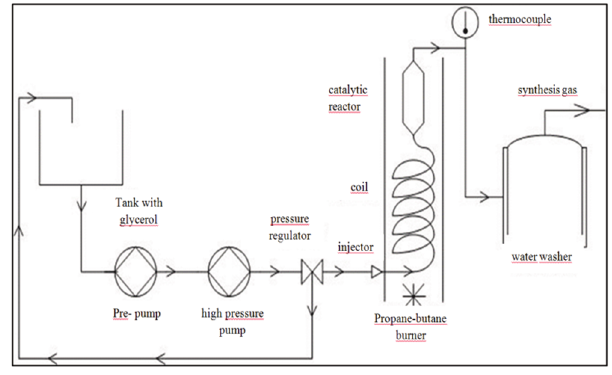
Fig. 6. Diagram of the installation for the production of syngas During the attempts to obtain syngas, both pure glycer- ine with a concentration of 99.5% was used. and